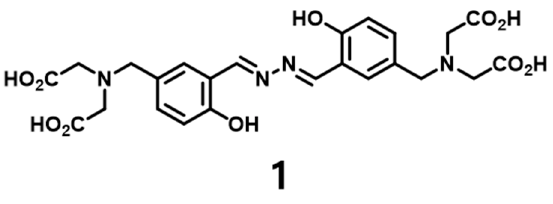
Figure 1. Chemical structure of compound 1 .